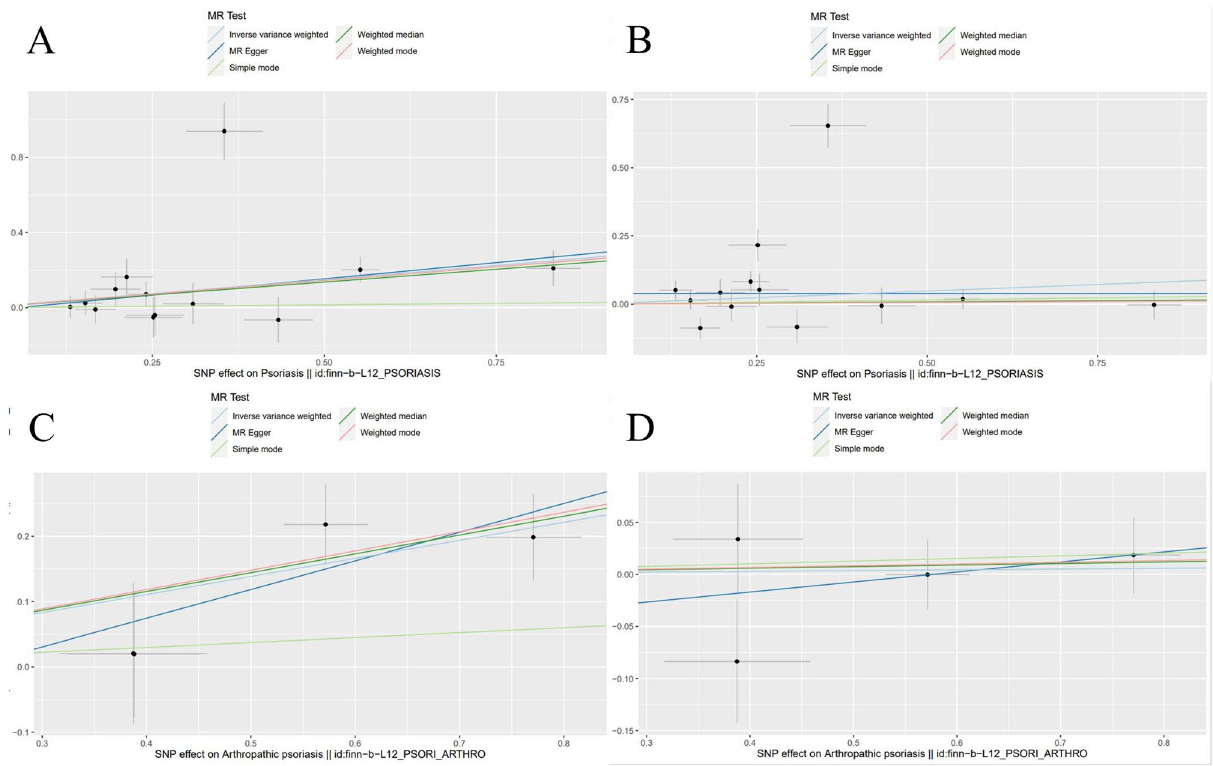
colitis, PsA psoriatic arthritis, SNP single nucleotide